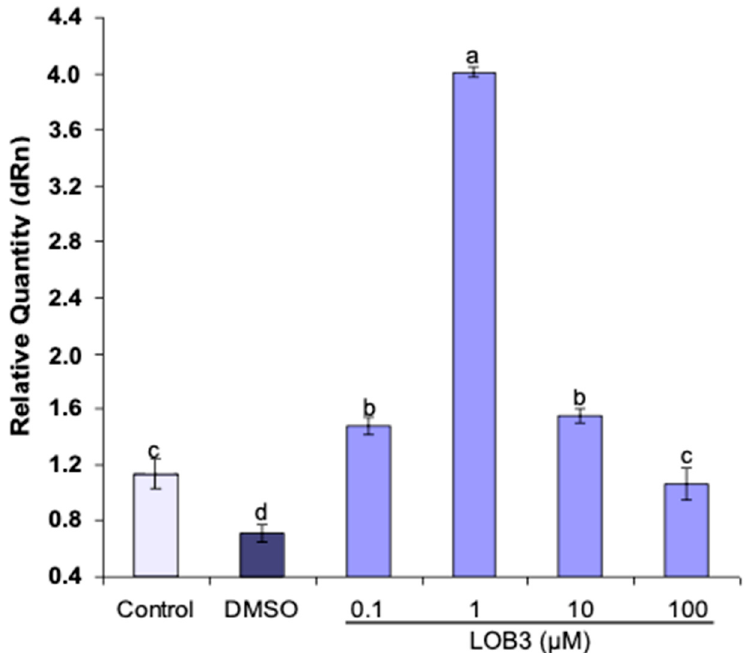
Figure 3. Induction of HSP 70A mRNA expression in C. elegans by LOB3 at different concentrations. The different letters (a–d) represent significance at p < 0.01. All samples were normalized to GAPDH expression. An Unamended culture medium and DMSO were used as the control treatment and negative control, respectively. Mean HSP 70 values and SDs from three repetitions shown. Data were analyzed by one-way ANOVA followed by Duncan’s multiple range test. Values not sharing a common letter are significantly different ( p < 0.01).